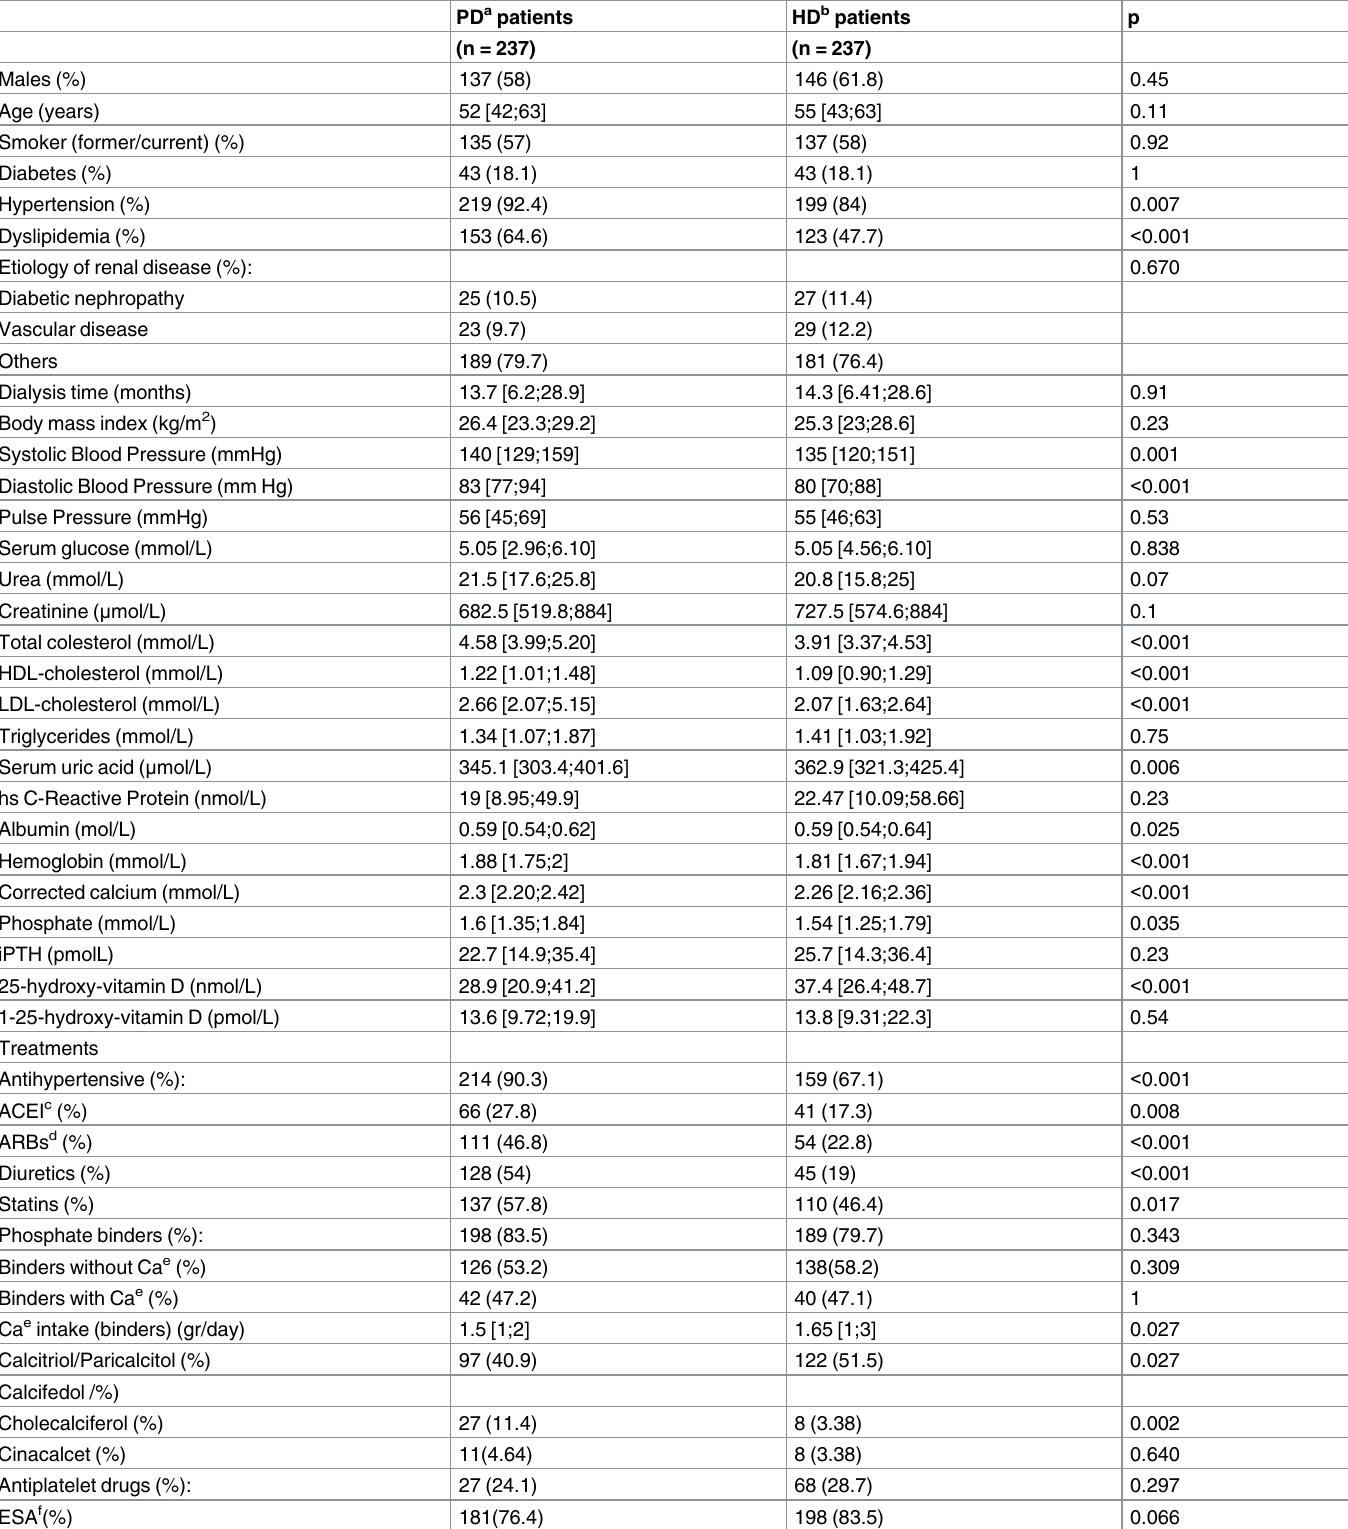
Table 1. Main Baseline characteristics according to dialysis